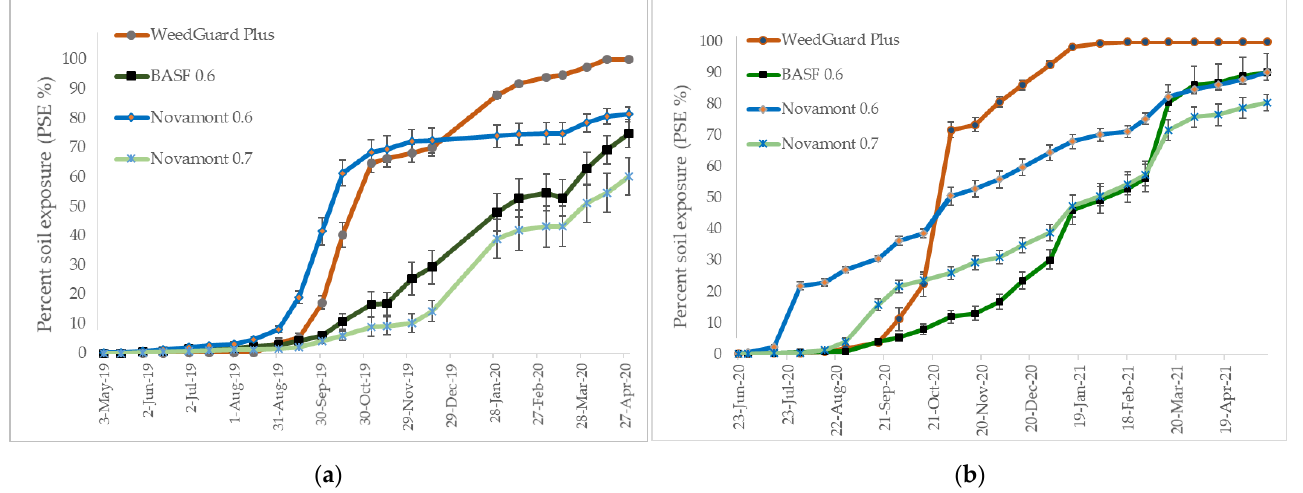
Figure 3. Percent soil exposure (PSE) of soil-biodegradable mulches (BDMs) (BASF 0.6, Novamont 0.6, Novamont 0.7 and WeedGuard Plus, where 0.6 = 15.2 μm thickness and 0.7 = 17.8 μm